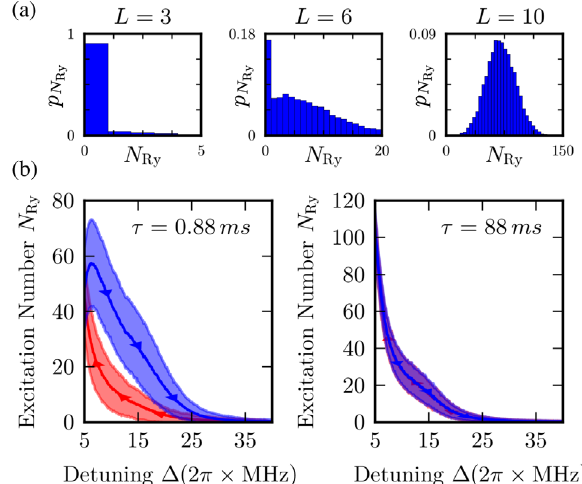
FIG. 7. (a) Excitation number probability p for Ω ¼ 2 π × N Ry 185 kHz and Δ ¼ 2 π × 15 MHz for three different linear system sizes L after 1-ms propagation. For intermediate system size ( L ¼ 6 ), the distribution shows a bimodal behavior. (b) Hysteresis scan in the detuning parameter Δ for Ω ¼ 2 π × 160 kHz with linear system size L ¼ 10 . The sweep times in the forward and backward directions are τ ¼ 0 . 88 ms and τ ¼ 88 ms. In the case of a large sweep time τ ¼ 88 ms, the dynamic hysteresis disappears. The mean Rydberg excitation number in the back- ward and forward scans are averaged over 500 trajectories. The standard deviation is indicated by the shaded